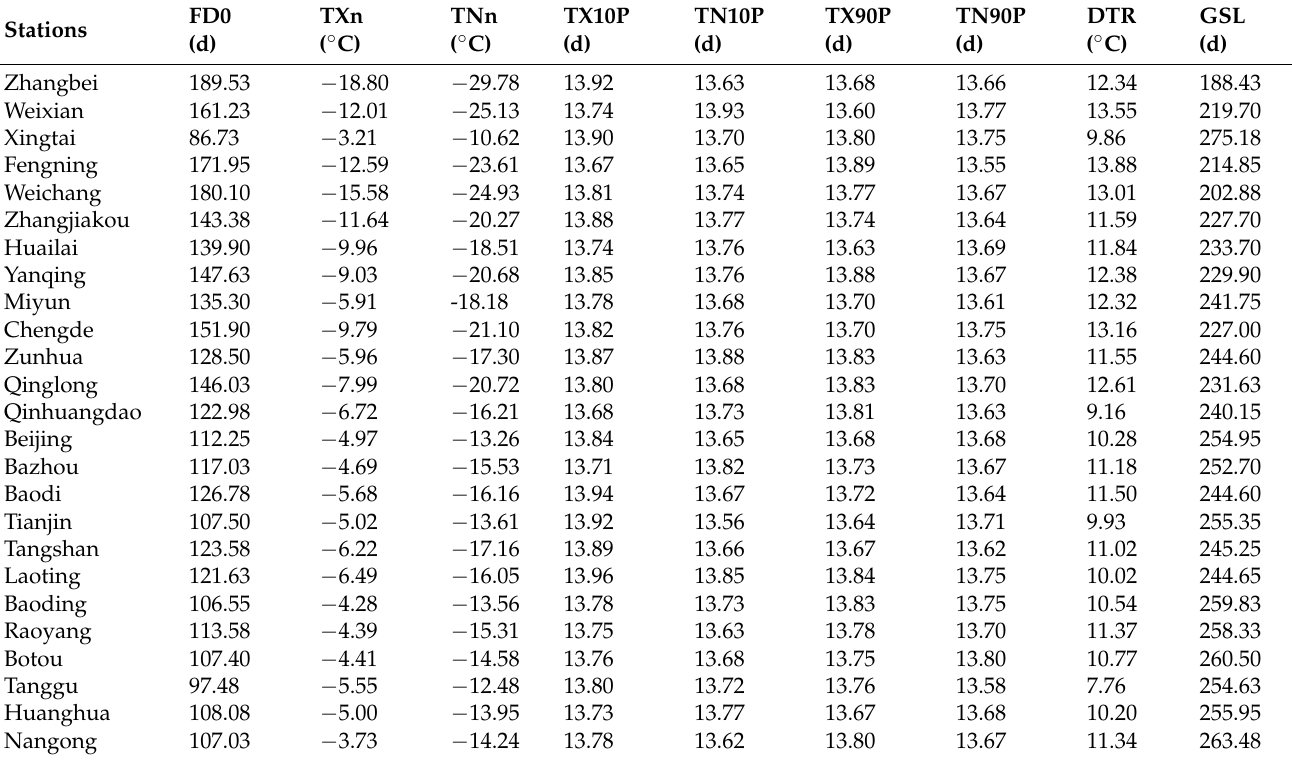
Table 3. Extreme temperature indices at 25 meteorological stations in the Beijing–Tianjin–Hebei region from 1980 to